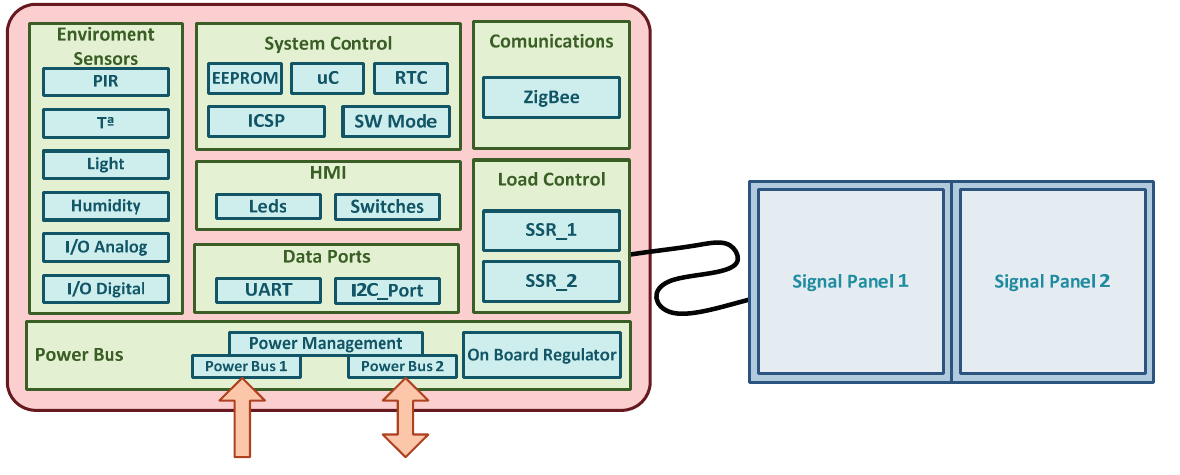
Figure 6. Block diagram of the electronic